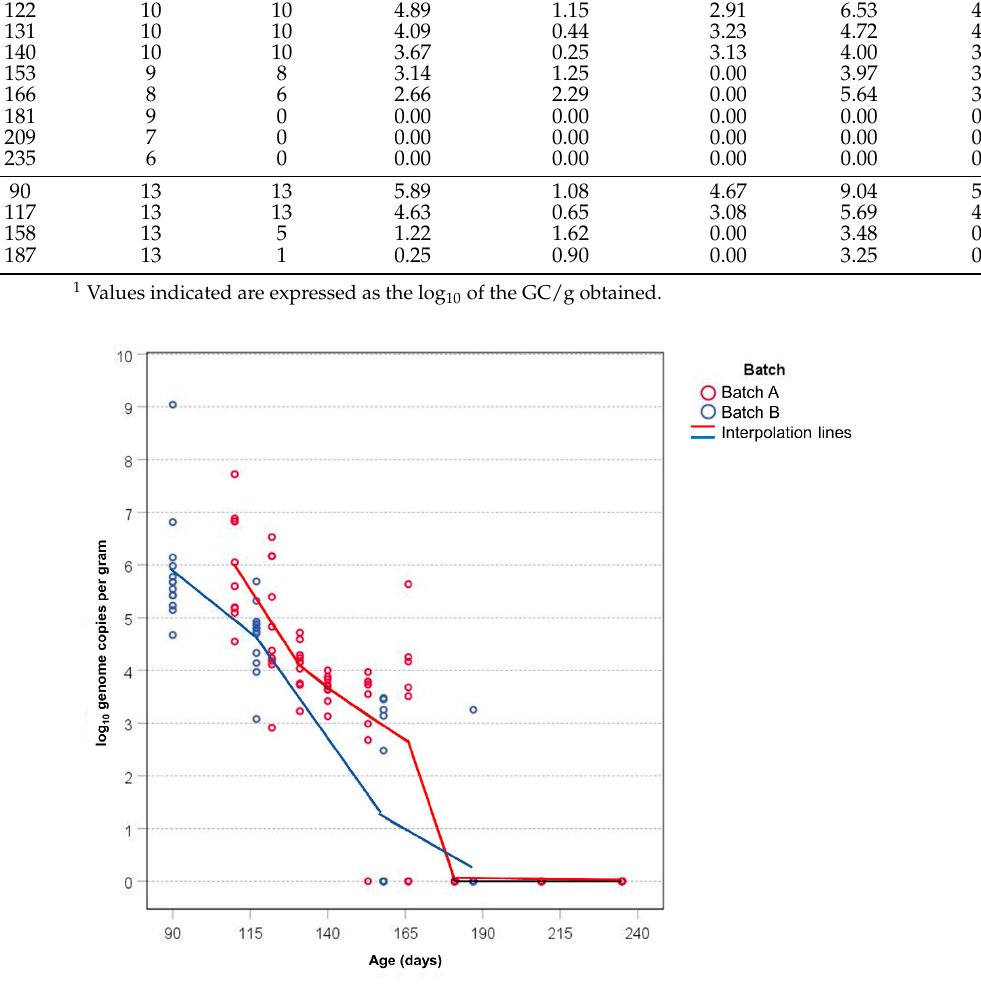
Figure 3. Amount of HEV-RNA expressed as log 10 genome copies (GC) per gram of feces shed by each animal during the whole survey. Single values of GC for each pig are indicated by circle. The red colored points and line are referred to batch A, the blue to batch